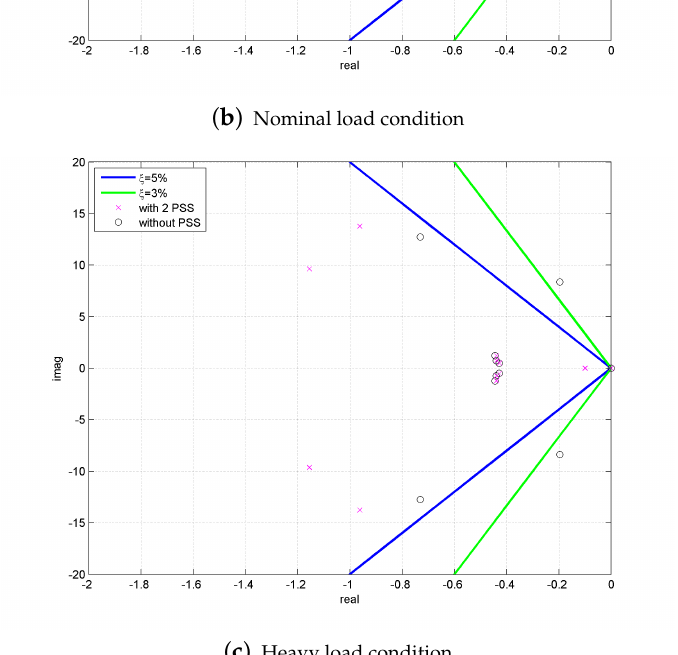
Figure 13. Three-machine—nine-bus under different load